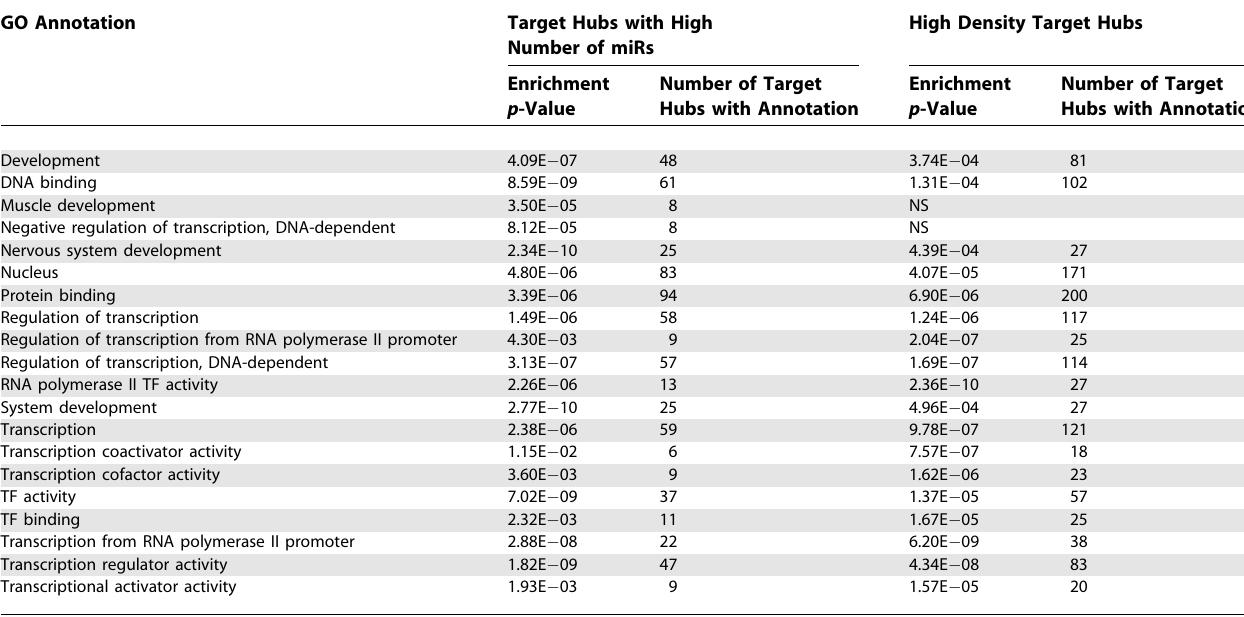
Table 1. TargetScan Target Hubs GO Functional Enrichment GO